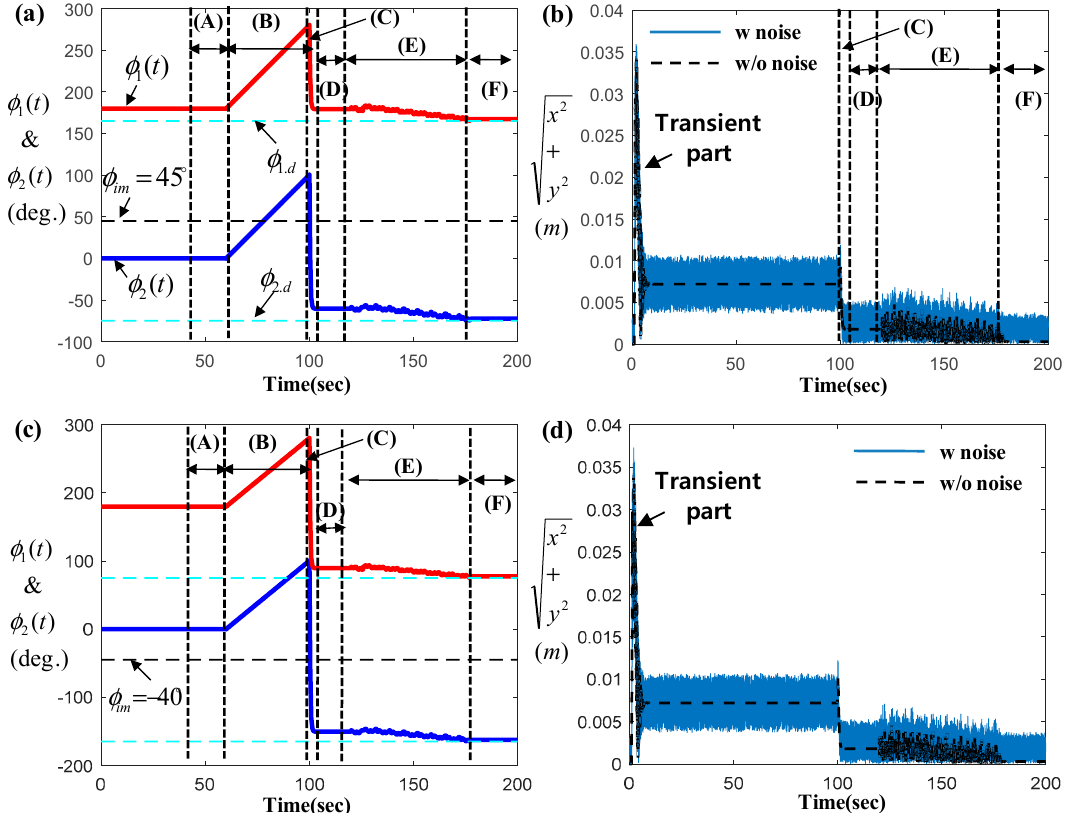
Figure 8. Angular position control AAEMS (LQR-based optimal control + trial–error fine-tuning control). (( a ) and ( c ) indicate the angular position of AAEMS and ( b ) and ( d ) are the vibration amplitude of rotor.).